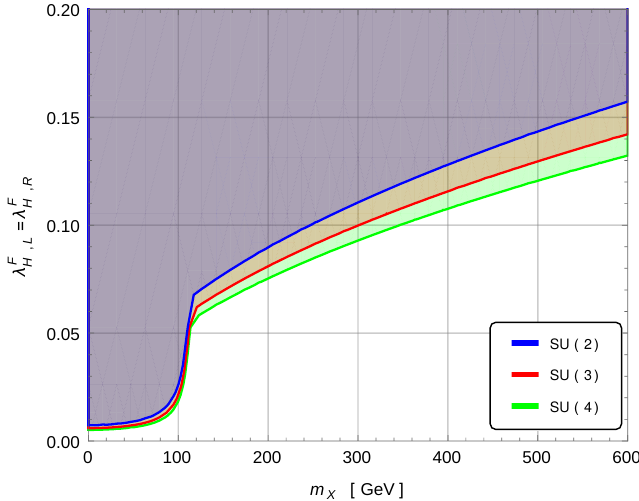
Figure 7. Excluded region at 95% con(cid:12)dence level in the ( m X , (cid:21) F branching ratio to semivisible jets for di(cid:11)erent G . The mass m N was set to 10